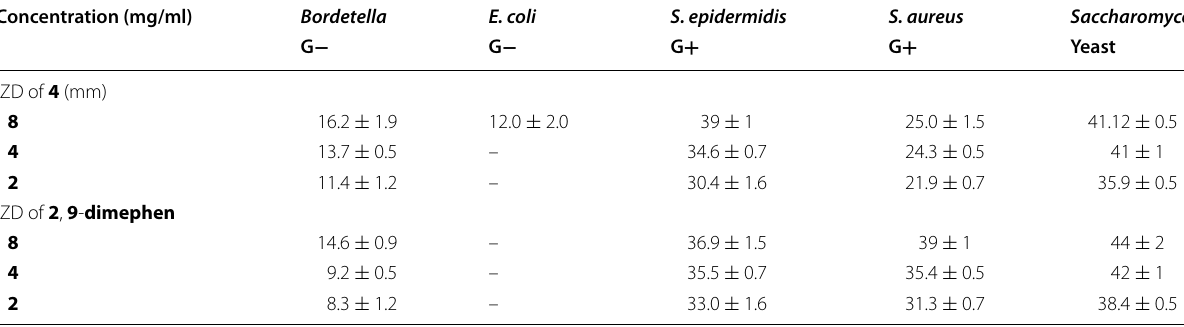
Table 5 Comparison of anti-bacterial activity of complex 4 with 2,9-dimephen Concentration